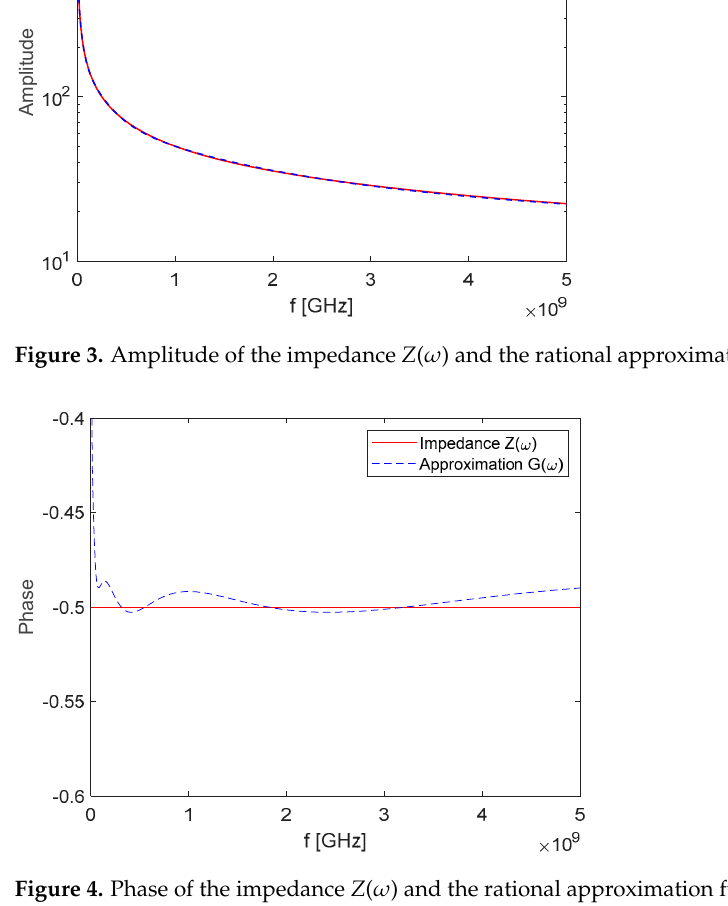
Figure 4. Phase of the impedance Z ( ω ) and the rational approximation function G ( ω ).